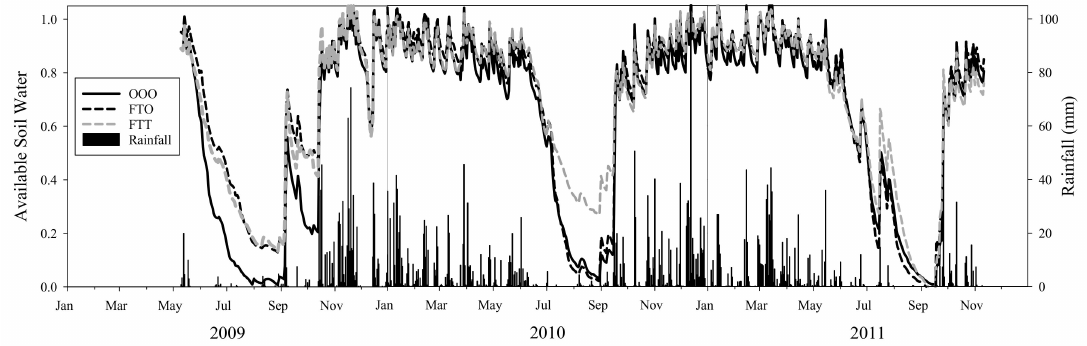
Figure 3. E ff ect of vegetation management regime on available soil water during the first three growing seasons (5 September 2009–11 November 2011). Daily precipitation is depicted by the vertical bars. Treatment descriptions are provided in Table 1.